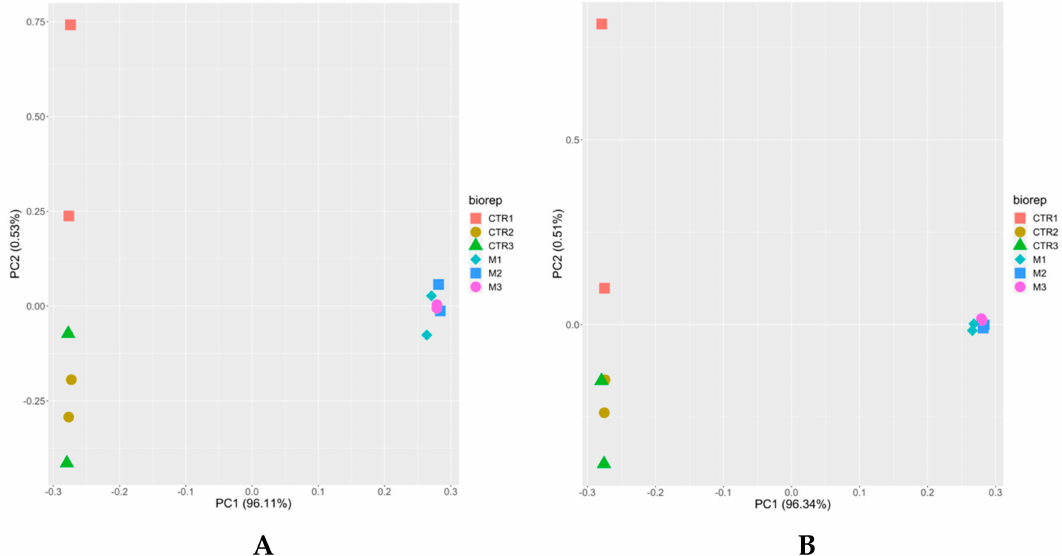
Figure 2. Principal component analysis of proteome data sets from N. caninum tachyzoites and from MNCs induced by BKI-1294 treatment. Tachyzoites and MNCs were grown, purified and subjected to MS shotgun analysis as described in the Materials and Methods. All technical and biological replicates are shown, namely red square, brown circle, and green triangle for tachyzoites (CTR), and pink circle, blue square, and turquoise diamond for MNCs (M). ( A ) iTop3 data; ( B ) iLFQ data.